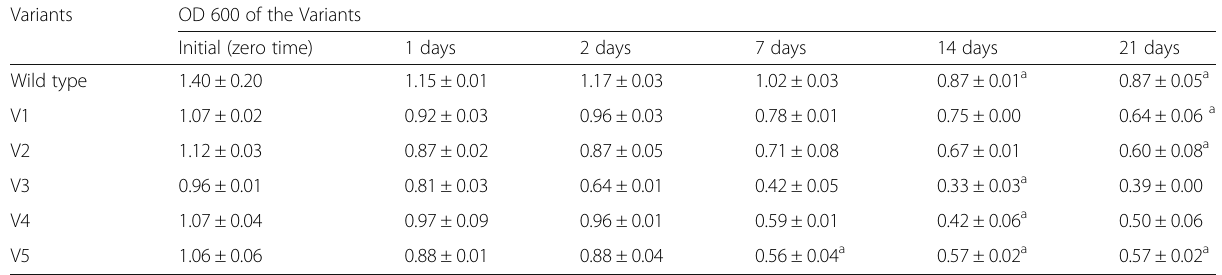
Table 1 The growth of the wild type and variants during 21 days incubation. Data expressed as mean ± standard deviation Variants